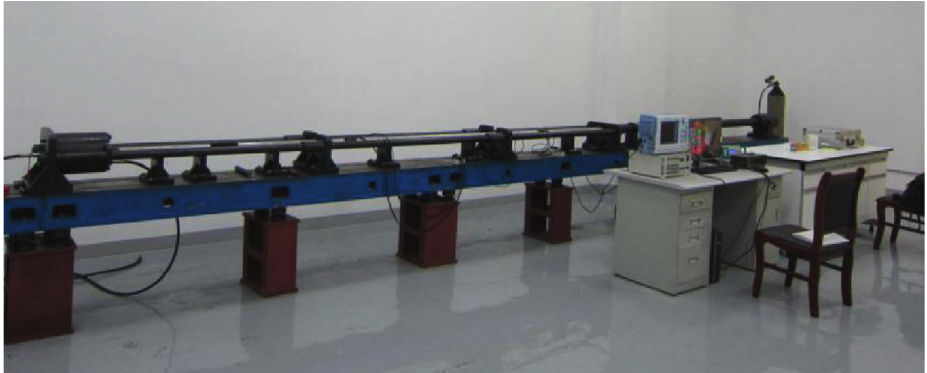
Figure 4: SHPB test device.